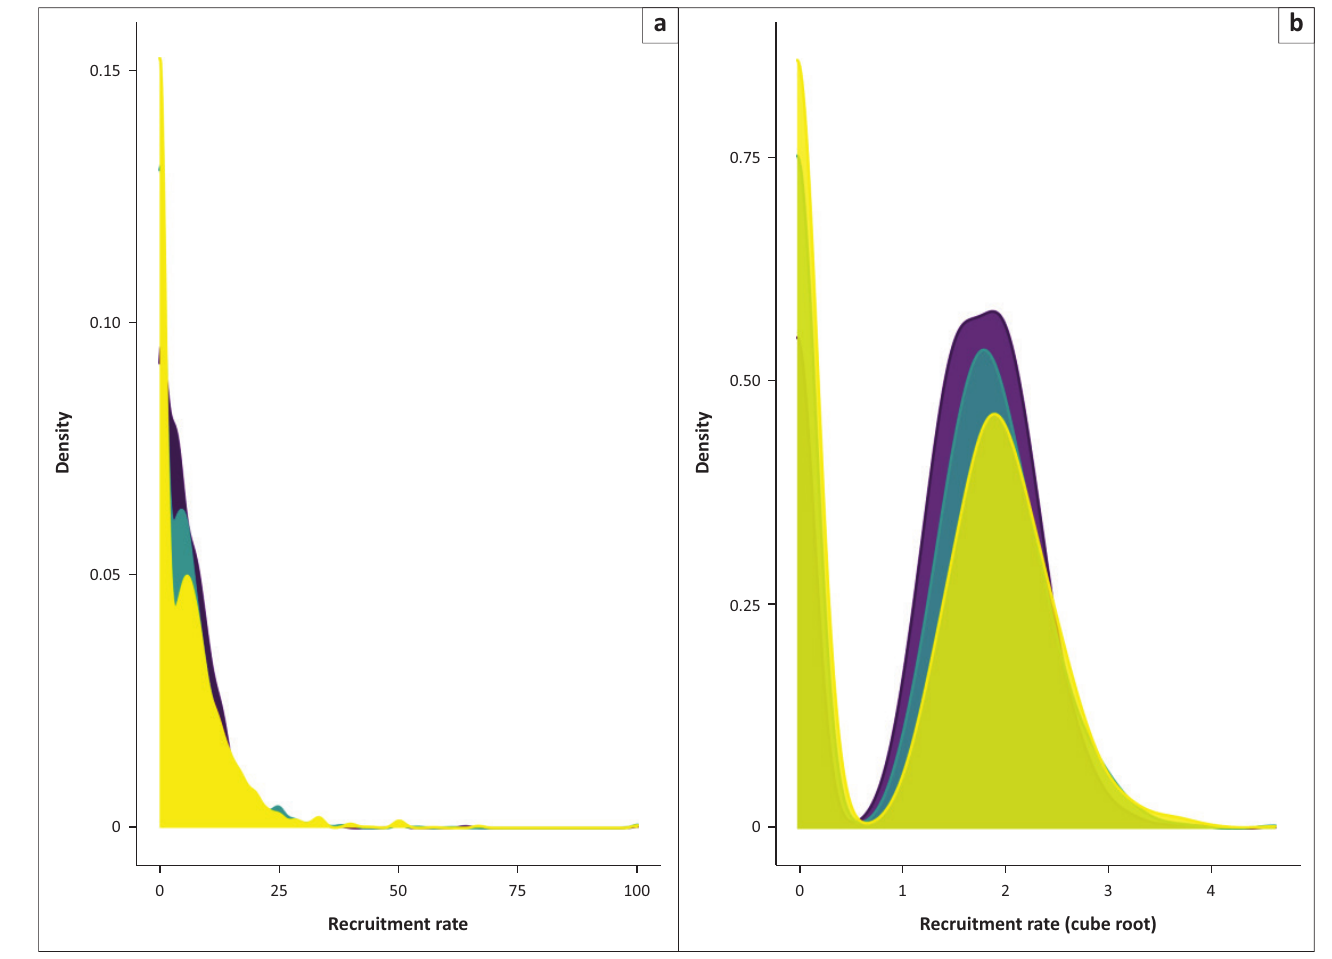
KNP, Kruger National Park. FIGURE 2-A1: Distribution plots of Recruitment rate observations. (a) Shows recruitment rates are skewed and (b) shows a cube root transformation of the recruitment rates, to reduce